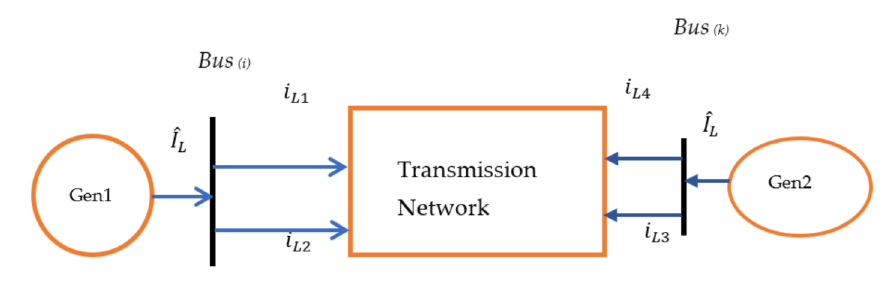
Figure 1. Sample nodal network in modular